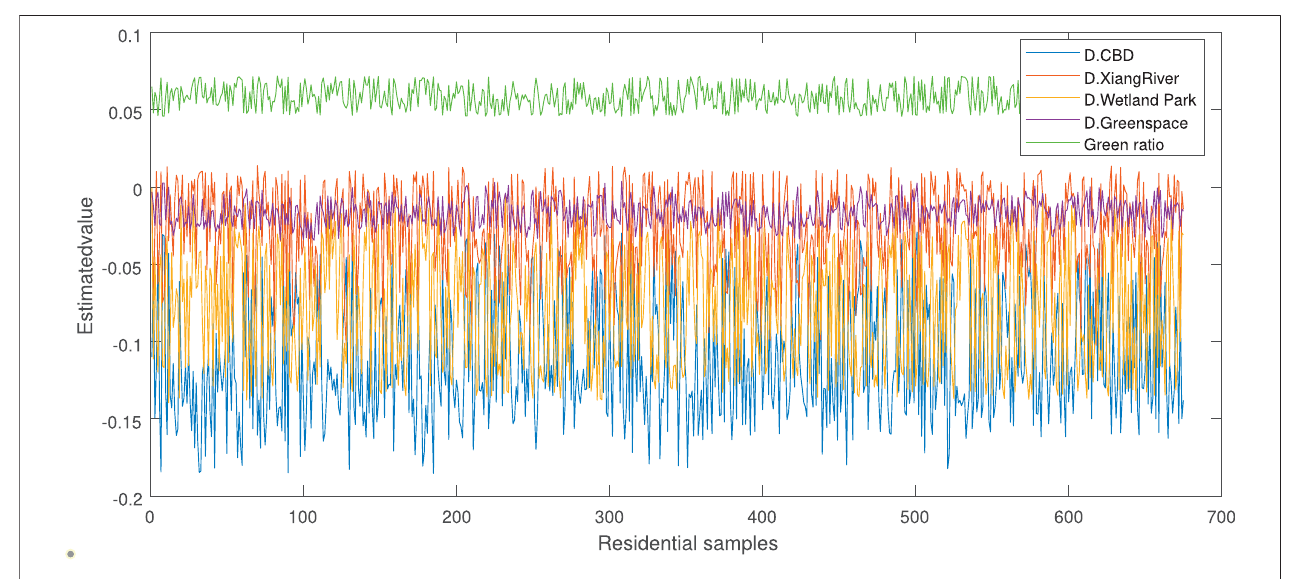
FIGURE 11 | Key coef fi cients divergence in 2016.